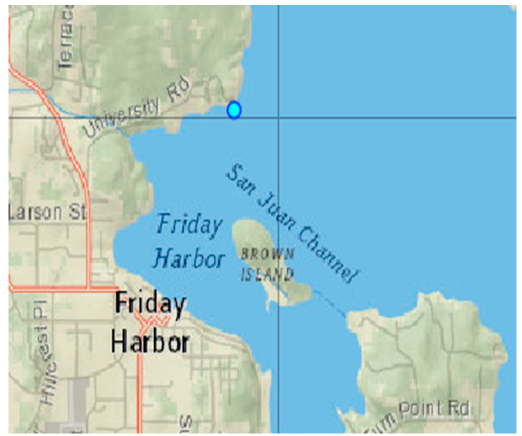
Figure 3. The geographical location of the sc02 station.